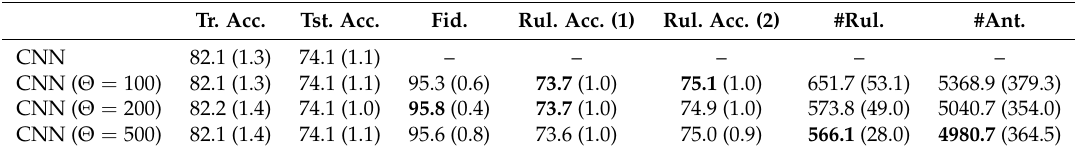
Table 3. Average results based on cross-validation. The models are CNNs and interpretable CNN approximations with varying numbers of stairs in the staircase activation function. Standard deviations are given between